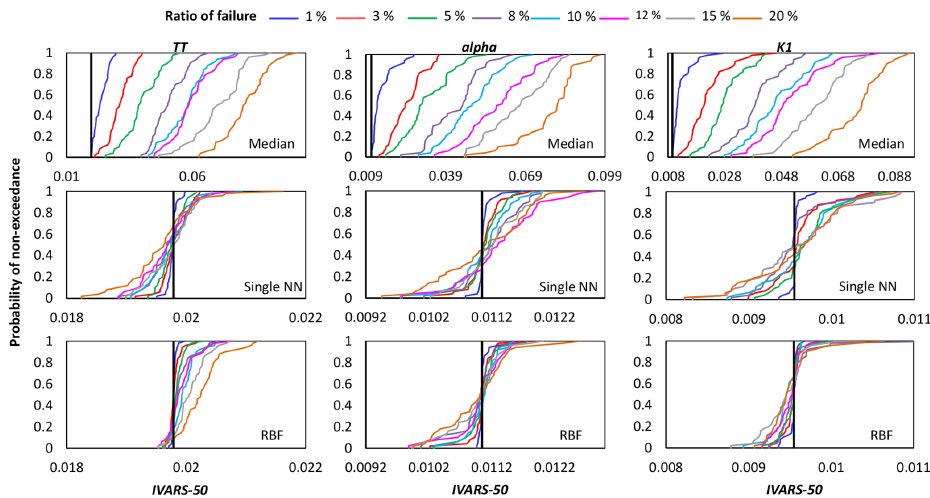
Figure 5. Comparison of the proposed crash-handling strategies in a sensitivity analysis of the HBV-SASK model using the STAR-VARS algorithm for different ratios of failure. The CDFs of the sensitivity indices for moderately influential parameters { TT , alpha , K1 } are com- pared in this plot. The vertical line (solid black) on each subplot represents the corresponding “true” sensitivity index obtained when there were no